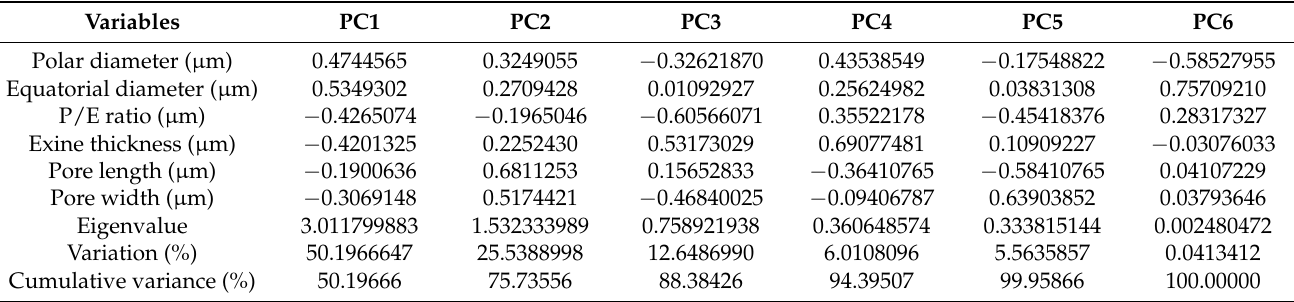
Figure 6. Principal component analysis (PCA) among the studied salt-tolerant Poaceae species based on palyno-morphological characteristics. ( Calamagrostis pseudophragmites , Cenchrus biflorus , Cenchrus ciliaris , Cenchrus pennisetiformis , Cymbopogon jwarancusa , Dactyloctenium aegyptium , Echinochloa colona , Echinochloa crus-galli , Saccharum griffithii , Saccharum ravennae , Saccharum spontaneum , and Urochloa ramosa ). Table 3. Correlation coefficients for metric variables of principal component analysis (PCA) using palynological characteristics of salt-tolerant